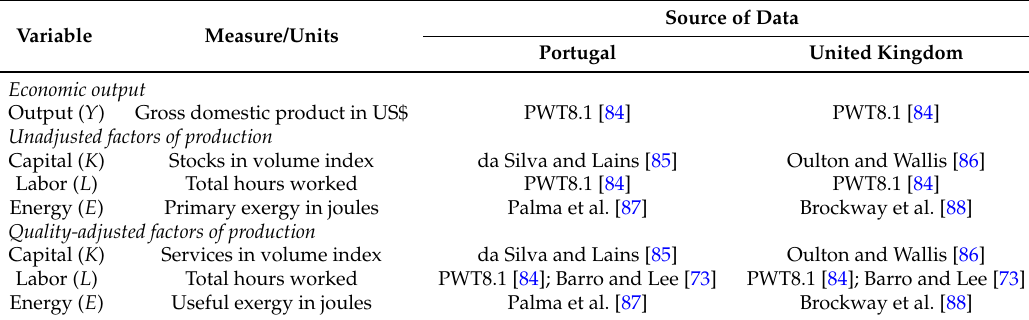
Figure 3. Historical economic data for Portugal and the United Kingdom. All time series are indexed (by ratio) to 1960. Table 3. Measures and sources of economic output and factors of